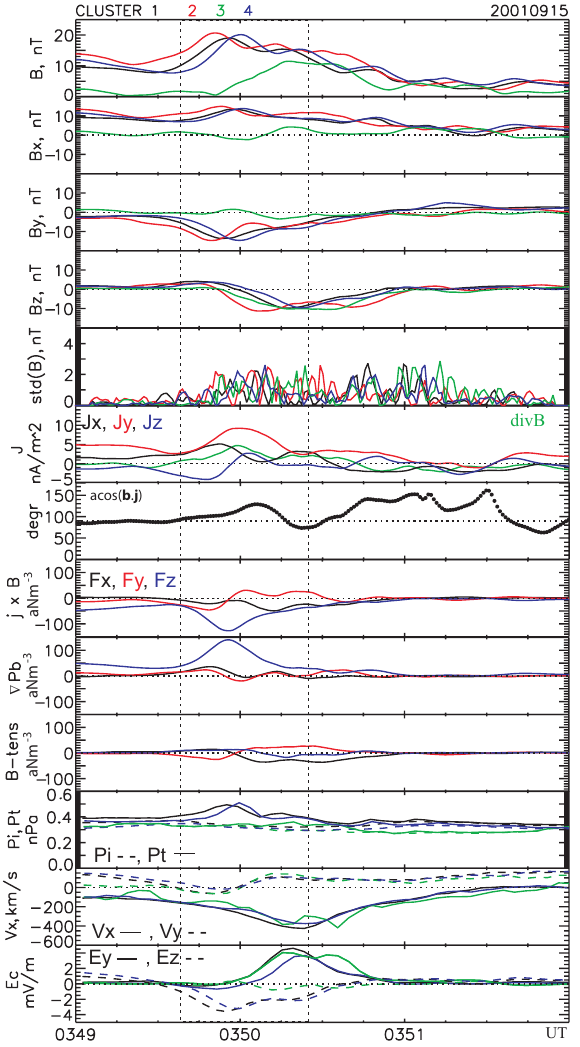
Fig. 9. Cluster observation during interval B : The same format as in Fig.